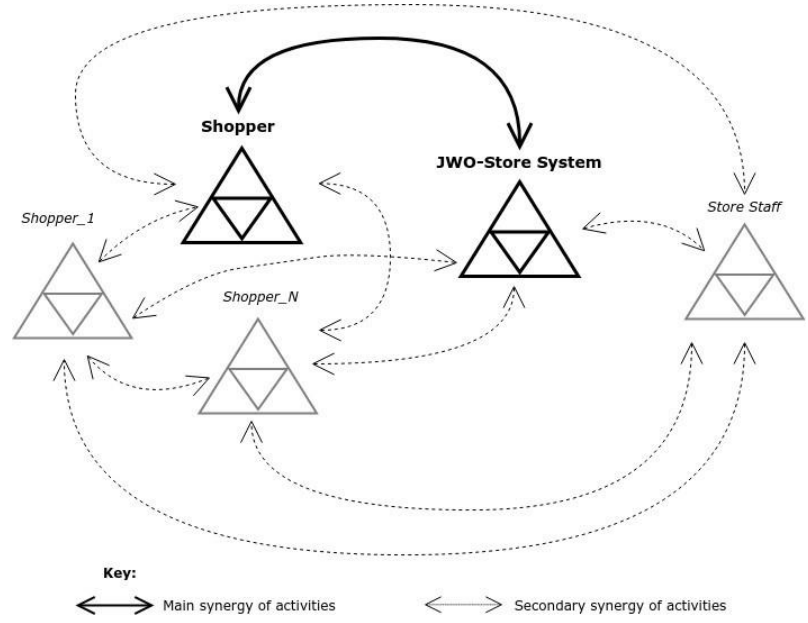
Figure 3. Representation of the NoA for the scenario proposed (simplified form).